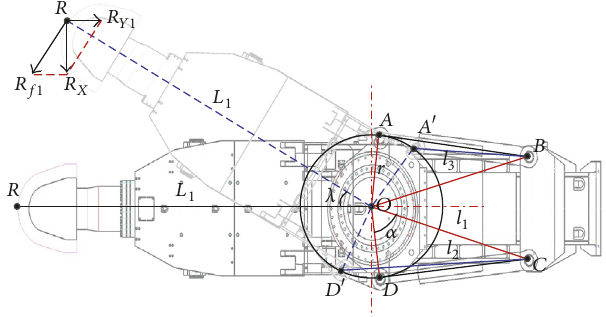
Figure 4: Two-dimensional diagram of the cutting arm during the vertical swing